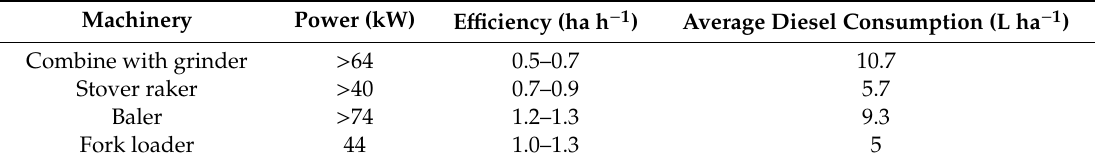
Table 3. Technical parameters of machinery used in corn stover collection based on the field